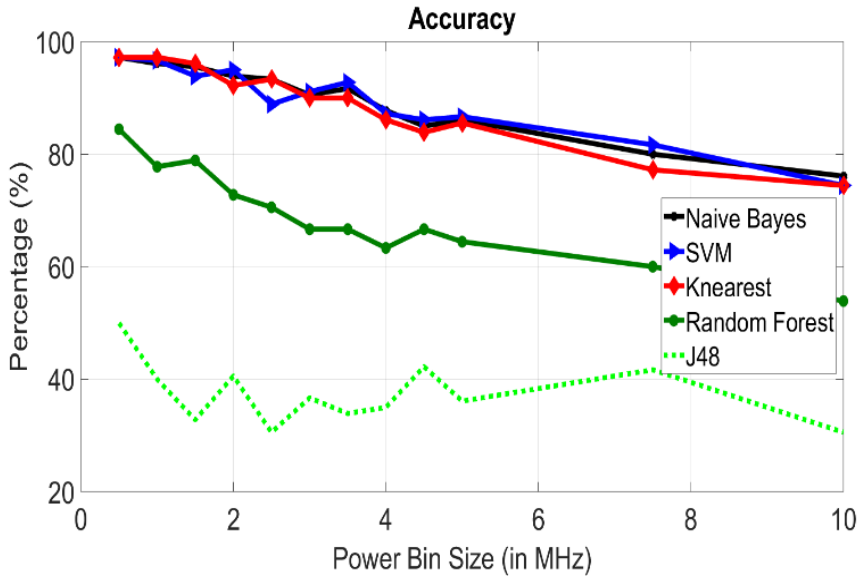
Figure 4. Accuracy for different classifiers versus power bin size.